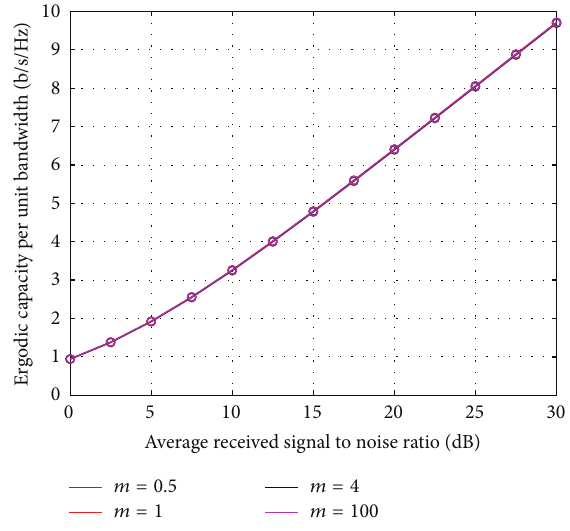
Figure 4: Influence of shadowing 𝑚 -parameter on the mean capacity values when the dominant component is less powerful than the scattered waves ( 𝜅 = 0.2 ). The value of 𝜇 -parameter is set to 3 in all curves. The marks correspond to results obtained by numerical